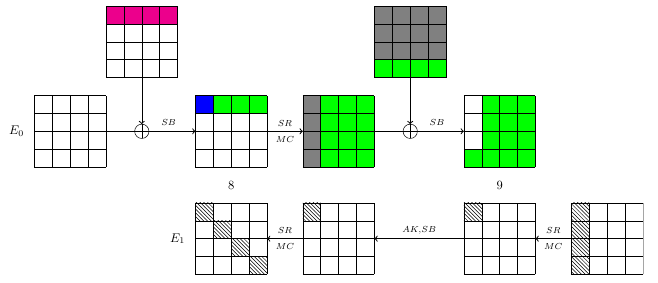
Figure 9: 2-round boomerang switch for the 9-round distinguisher against AES